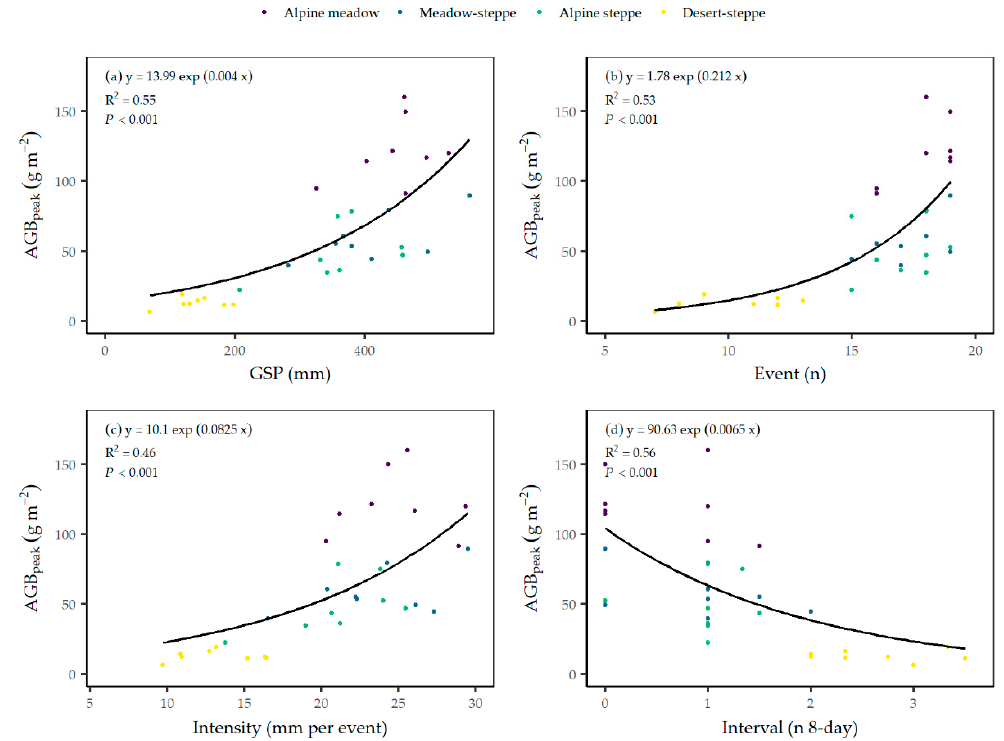
Figure 4. Relationships of peak aboveground biomass (AGB peak ) with ( a ) the total amount of growing season precipitation (GSP), ( b ) the number of precipitation events (Events), ( c ) the intensity of precipitation events (Intensity), and ( d ) the time interval between precipitation events (Interval) during the plant growing period at the four zonal sites, alpine meadow, meadow-steppe, alpine steppe, and desert-steppe on the northern Tibetan Plateau (see Figure 1 for site locations).